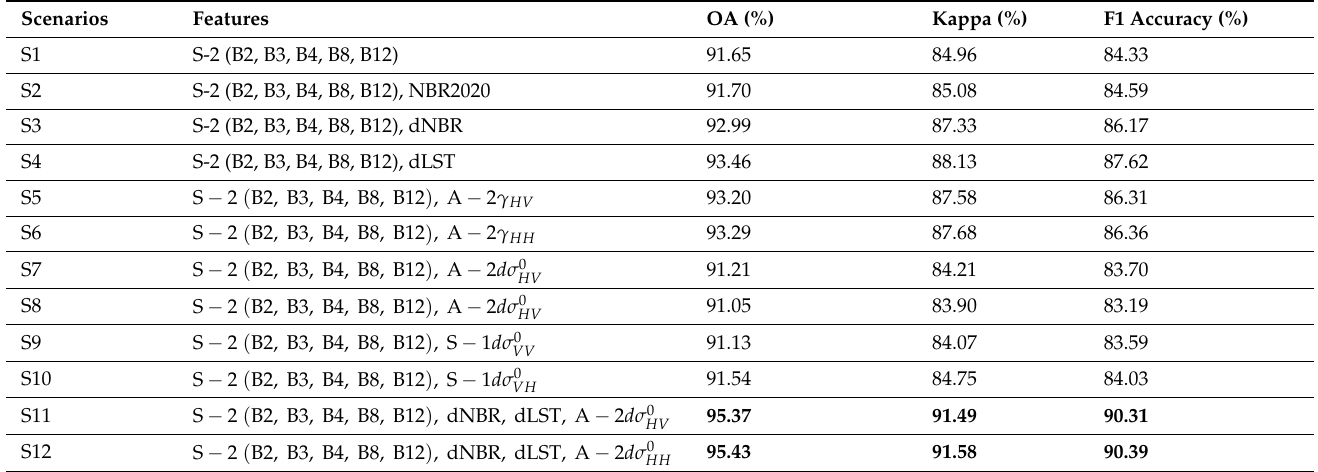
Table A1. Accuracy analysis of each scenario. The best result of each accuracy metric is written in